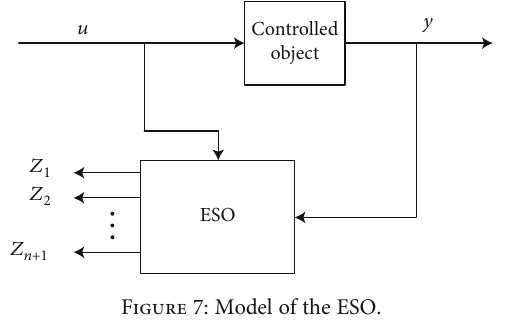
Figure 7: Model of the